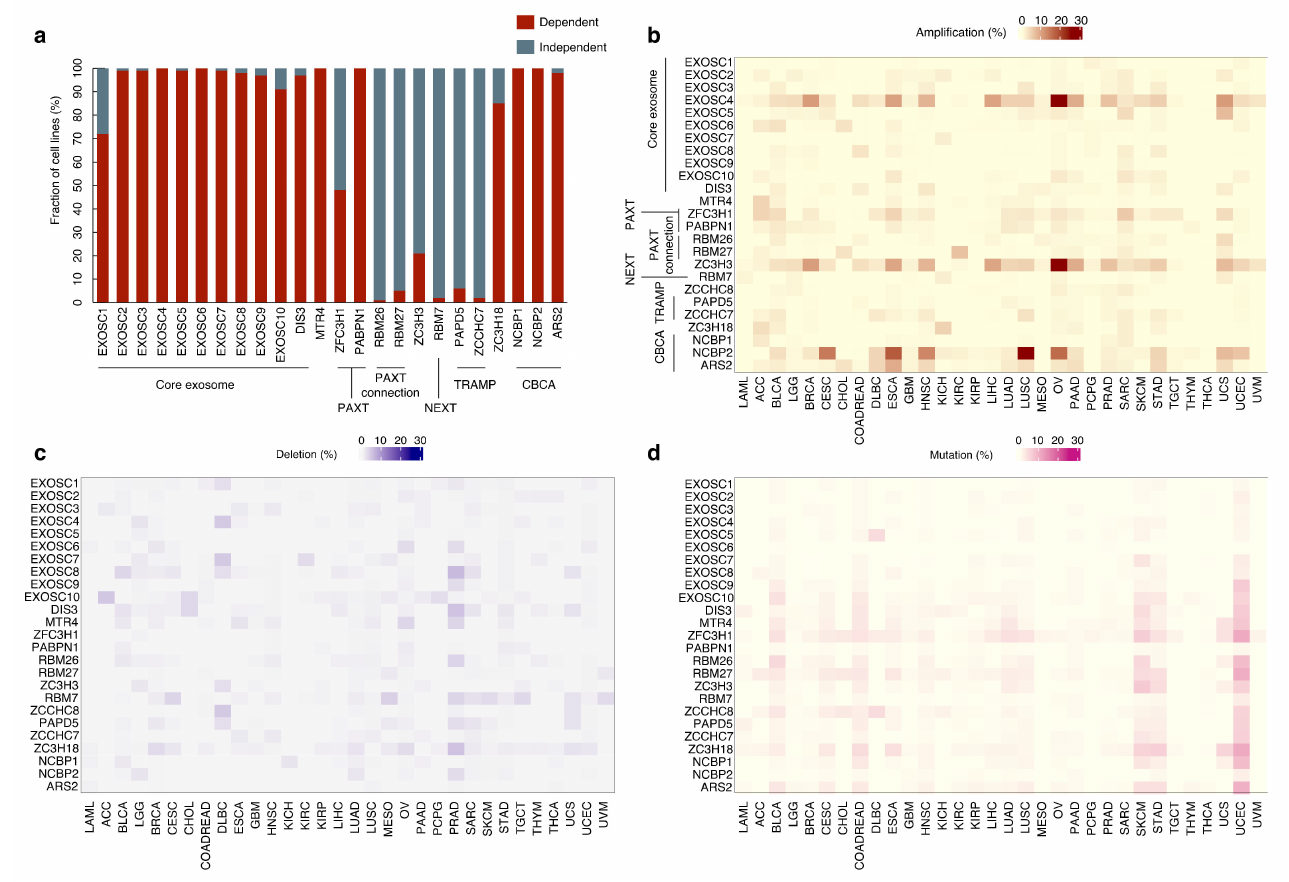
Figure 3. Dependencies on exosome-related genes in cancer cell lines and the alteration frequencies in human cancers. ( a ) A chart showing the percentage out of 1054 cancer cell lines, in which the dependency for a given CRISPR target gene is identified in the Cancer Dependency Map (DepMap). A cell line with a probability of dependency greater than 0.5 was considered as dependent [101]. Note that the data for a NEXT component ZCCHC8 is unavailable in DepMap. ( b – d ) Heatmaps showing the percentage of TCGA cases, in which ( b ) amplifications, ( c ) deletions or ( d ) mutations in given genes were evident. DepMap and cBioPortal were accessed in November of 2021. LAML, Acute Myeloid Leukemia; ACC, Adrenocortical Carcinoma; BLCA, Bladder Urothelial Carcinoma; LGG, Brain Lower Grade Glioma; BRCA, Breast Invasive Carcinoma; CESC, Cervical Squamous Cell Carcinoma and Endocervical Adenocarcinoma; CHOL, Cholangiocarcinoma; COADREAD, Colorectal Adenocarcinoma; DLBC, Diffuse Large B-Cell Lymphoma; ESCA, Esophageal Carcinoma; GBM, Glioblastoma Multiforme; HNSC, Head and Neck Squamous Cell Carcinoma; KICH, Kidney Chromophobe; KIRC, Kidney Renal Clear Cell Carcinoma; KIRP, Kidney Renal Papillary Cell Carcinoma; LIHC, Liver Hepatocellular Carcinoma; LUAD, Lung Adenocarcinoma; LUSC, Lung Squamous Cell Carcinoma; MESO, Mesothelioma; OV, Ovarian Serous Cystadenocarcinoma; PAAD, Pancreatic Adenocarcinoma; PCPG, Pheochromocytoma and Paraganglioma; PRAD, Prostate Adenocarcinoma; SARC, Sarcoma; SKCM, Skin Cutaneous Melanoma; STAD, Stomach Adenocarcinoma; TGCT, Testicular Germ Cell Tumors; THYM, Thymoma; THCA, Thyroid Carcinoma; UCS, Uterine Carcinosarcoma; UCEC, Uterine Corpus Endometrial Carcinoma; and UVM, Uveal